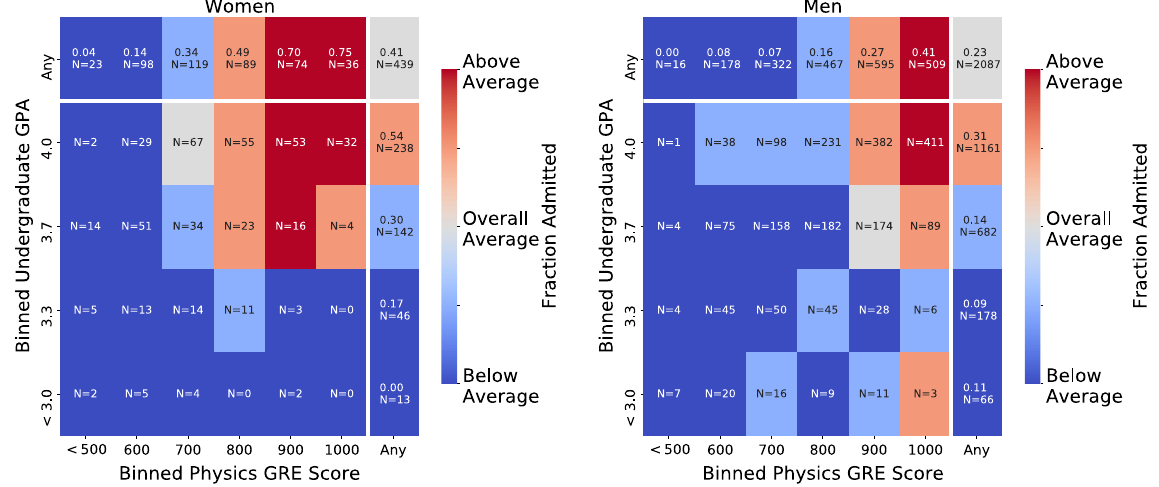
FIG. 7. Fraction of applicants admitted by undergraduate GPA and physics GRE score and split by the applicant ’ s gender.